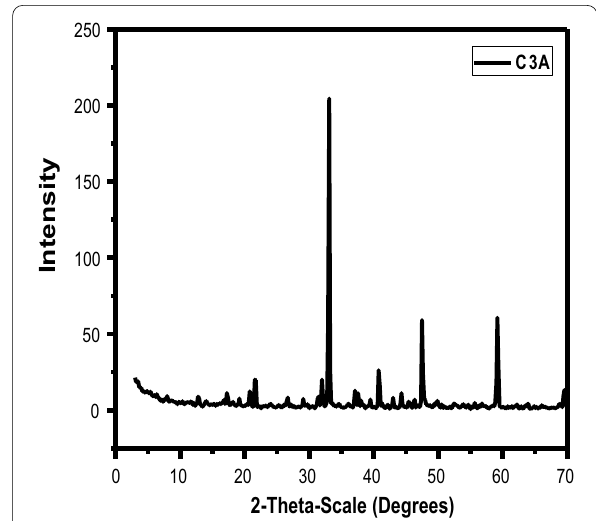
Fig. 1 X‑ray diffraction pattern of pure C 3 A phase